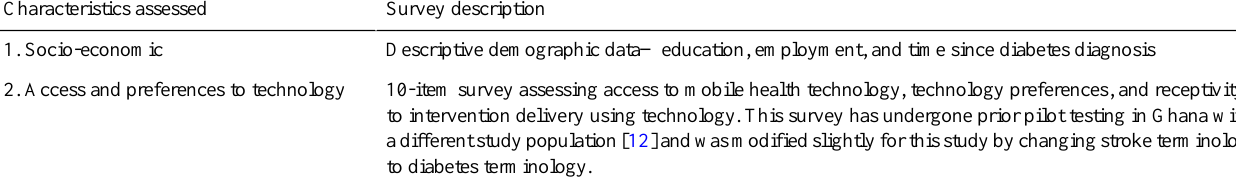
Survey descriptionCharacteristics